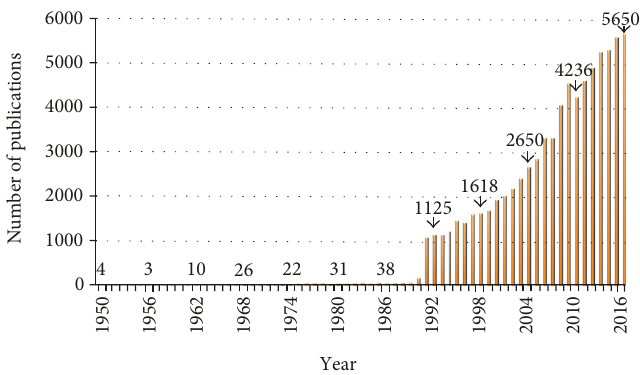
Figure 1: Growth of Web of Science-indexed publications, by year, using the key words “ lipid droplets, ” “ lipid bodies, ” “ adiposomes, ” or “ oil bodies, ” from 1950 to